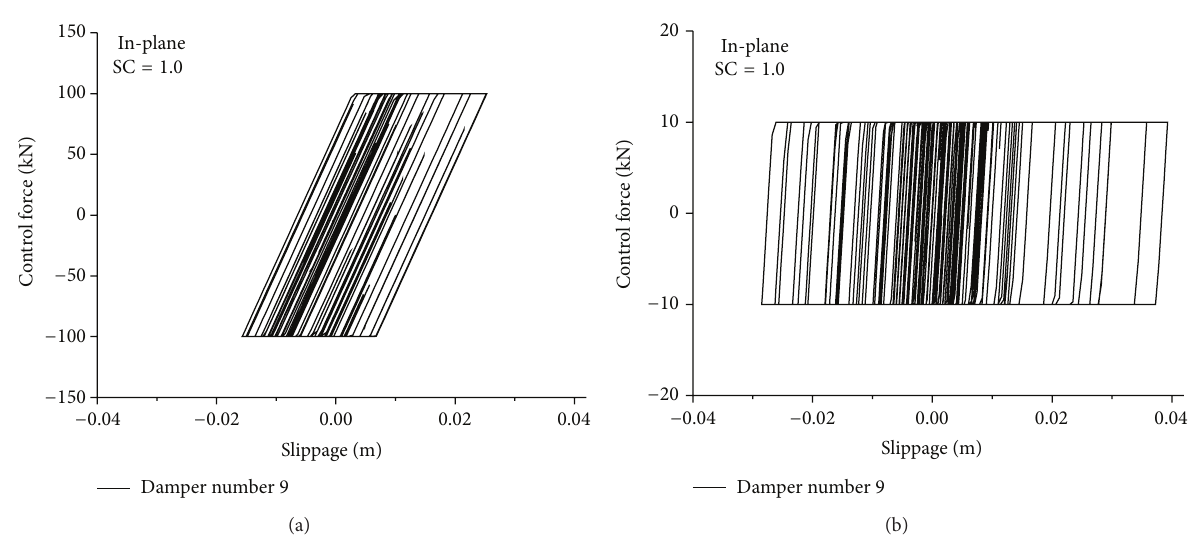
Figure 10: Hysteresis loops of friction damper for the in-plane vibration.